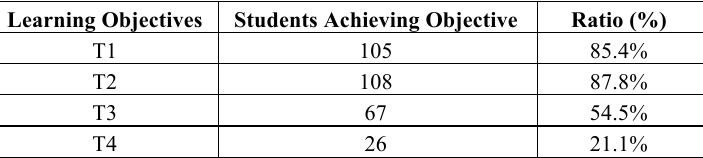
Table 3. Performance in the first four objectives of Sec. 3.1 (123 total